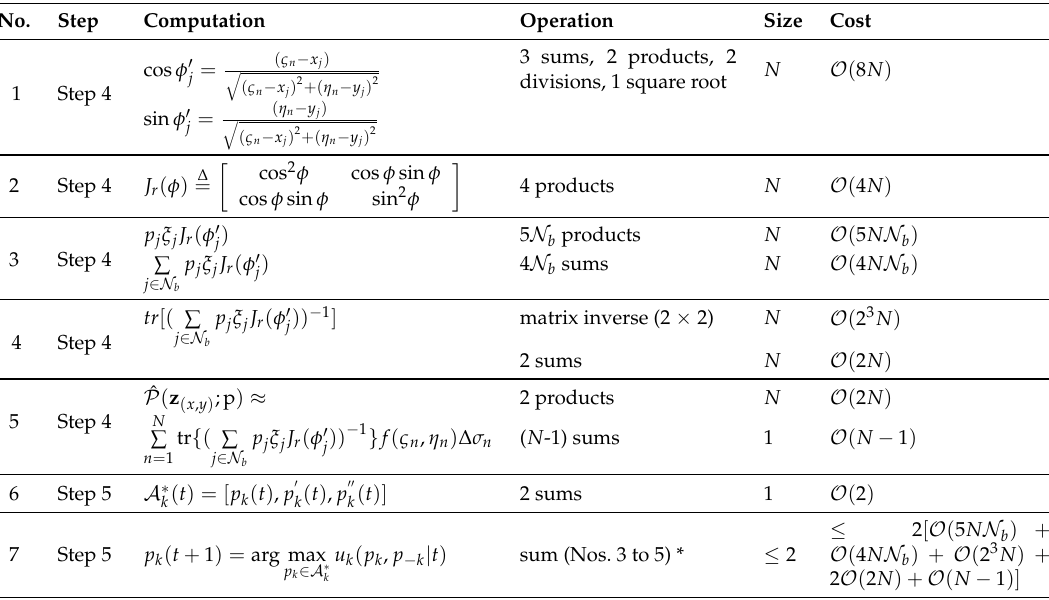
Table 1. Complexity of Algorithm